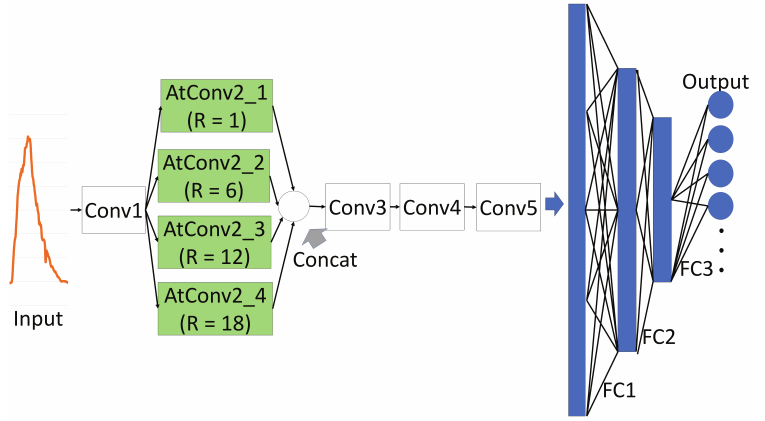
Figure 4. Proposed CNN Model, ODPA-CNN: AtConv is 1D-Atrous Convolution. Conv is normal 1D-Convolution. Table 1 has detailed parameters of each convolution. In this model, AtConv is processed in parallel to extract features for bands separated by various distances. Table 1. The parameters of